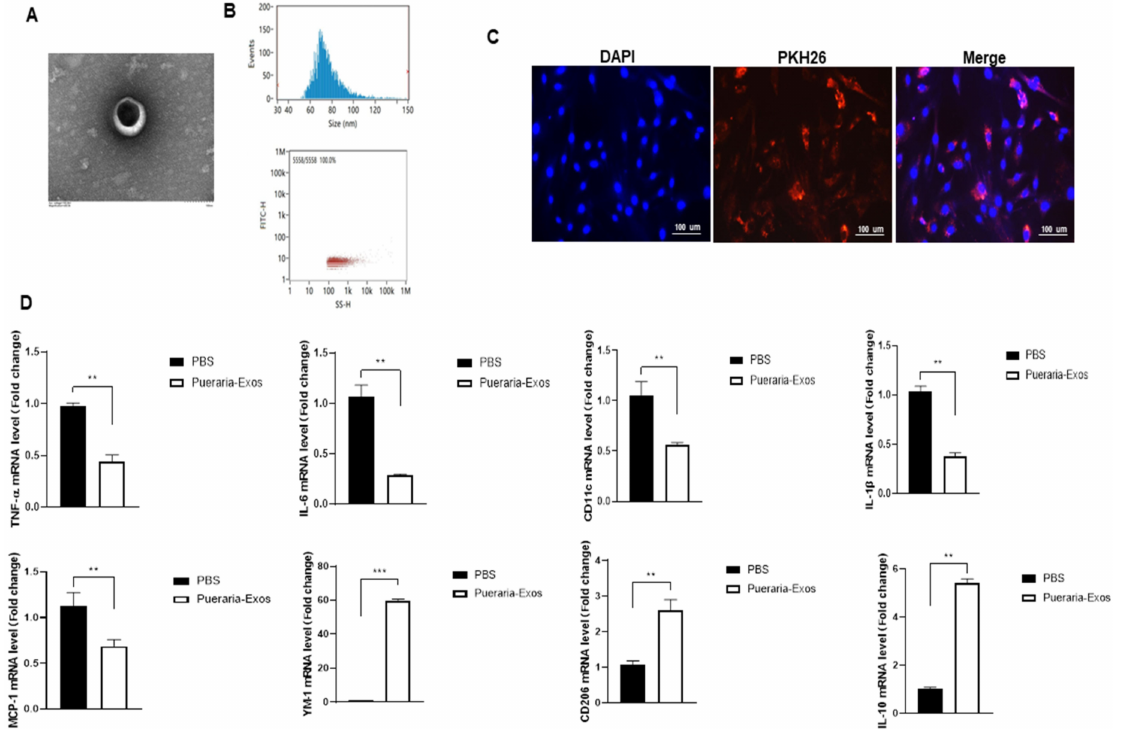
Figure 1. Characterization of exosomes isolated from P. lobata . ( A ) Transmission electron mi- croscopy (TEM) images of exosomes from P. lobata . Scale bar, 100 nm. ( B ) Particle size distribution of P. lobata -derived Exos measured by dynamic light scattering. ( C ) Fluorescence microscopy images of macrophages co-cultured with PKH67-labeled P. lobata -derived Exos for 6 h. All scale bars = 100 µ m. ( D ) The gene profiles of the M1 (IL-6, IL-1 β , TNF- α , MCP-1, and CD11c) and M2 (IL-10, YM1, and CD206) phenotypes as assessed by qPCR from macrophages in vitro. Data were normalized by